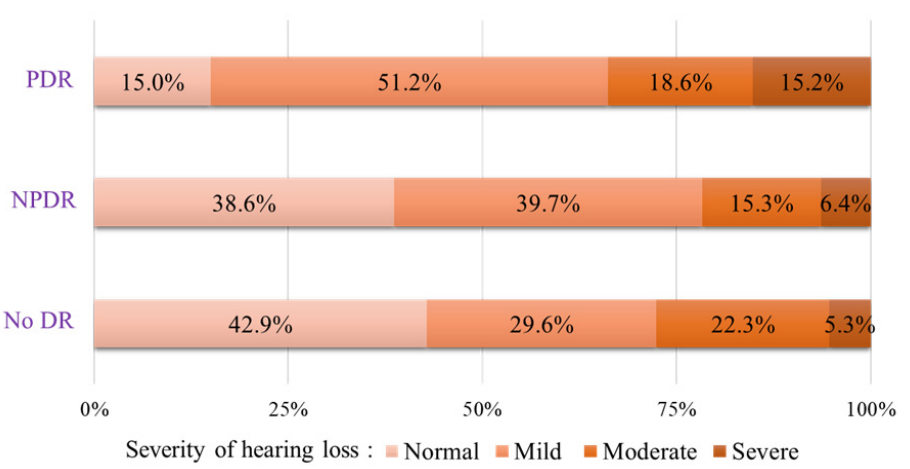
Figure 2. Distribution of the severity of hearing loss in patients with different degrees of diabetic retinopathy. Patients with PDR and NPDR were more likely to have hearing loss than patients without DR. PDR, proliferative diabetic retinopathy; NPDR, non-proliferative diabetic retinopathy; DR, diabetic retinopathy.